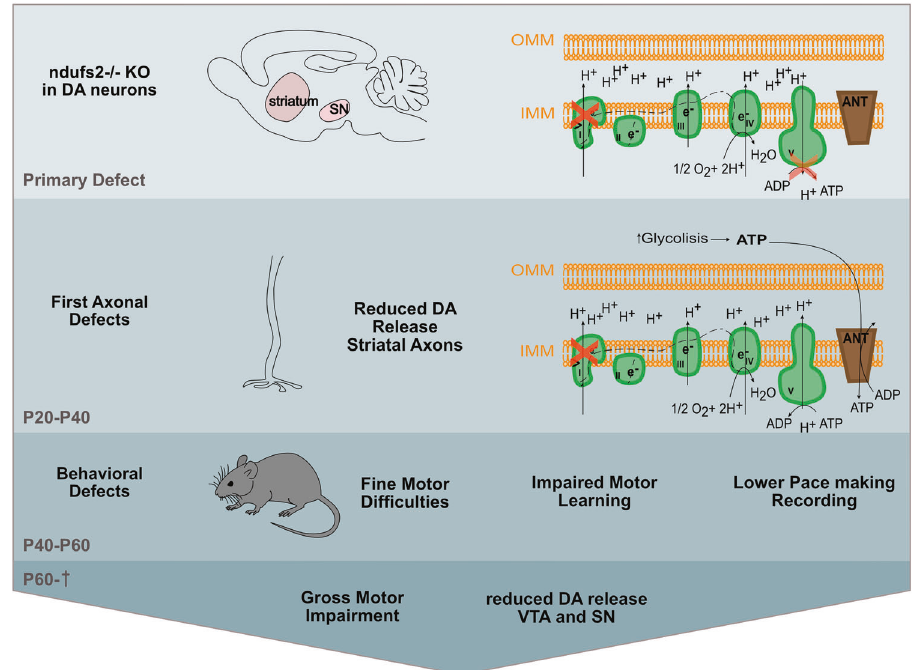
Fig. 1 Schematic representation of the sequence of events following ndufs2 − / − knock out (KO) in dopaminergic neurons. Loss of ndufs2 in the dopaminergic neurons (Striatum and substantia nigra (SN) results initially in an inef fi cient OXPHOS (primary defect) followed by a metabolic shift to increased glycolysis and initial axonal defects presented as reduced release of dopamine in striatal axons (P20 – P40). As a consequence, fi rst behavioral phenotypes were observed in mice namely, they display fi ne motor abnormalities, impaired motor learning and lower pace making recordings (P40 – P60). In a late stage (P60 – death), also dopamine release from the SN and VTA is decreased further resulting into gross motor